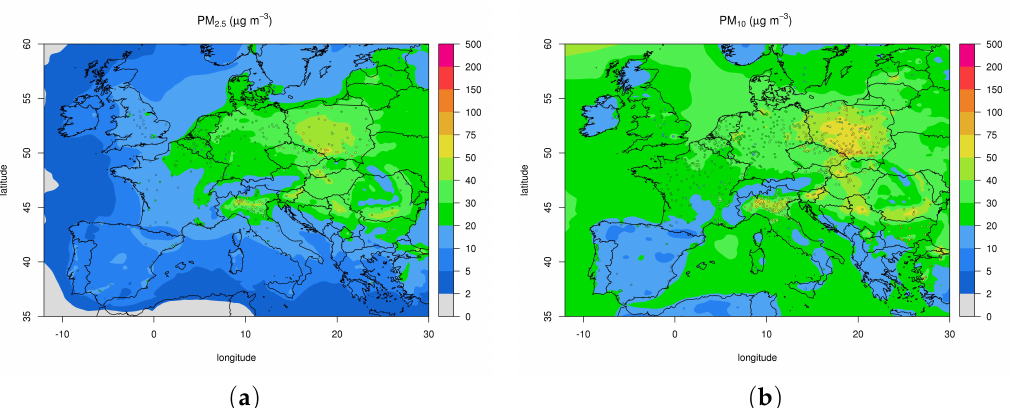
Figure 3. Seasonal average of model (maps) and measurements (filled circles) of PM 2.5 concentration ( µ g m − 3 ) ( a ) and PM 10 concentration ( µ g m − 3 ) ( b ) for DJF season.